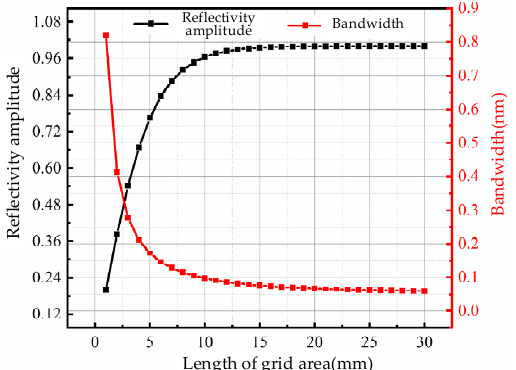
Figure 3. Spectral reflectance amplitude and bandwidth of FBG as a function of gate region length.